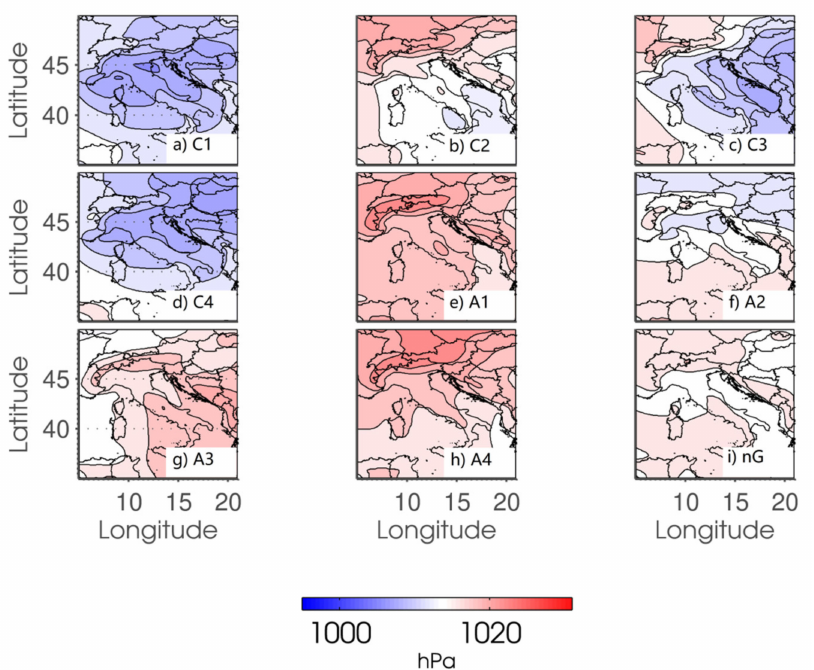
Figure 3. The 30-year mean of MSLP (including both deep and shallow cases) in the near-present period (1971–2000) for the JJA season. The presented example is for the RCA model forced by one of the GCMs (CNRM-CERFACS-CNRM-CM5). ( a ) Front sector of cyclone (C1), ( b ) upper sector of cyclone (C2), ( c ) back sector of cyclone (C3), ( d ) lower sector of cyclone (C4), ( e ) front sector of anticyclone (A1), ( f ) upper sector of anticyclone (A2), ( g ) back sector of anticyclone (A3), ( h ) lower sector of anticyclone (A4), ( i ) quasi-non-gradient field